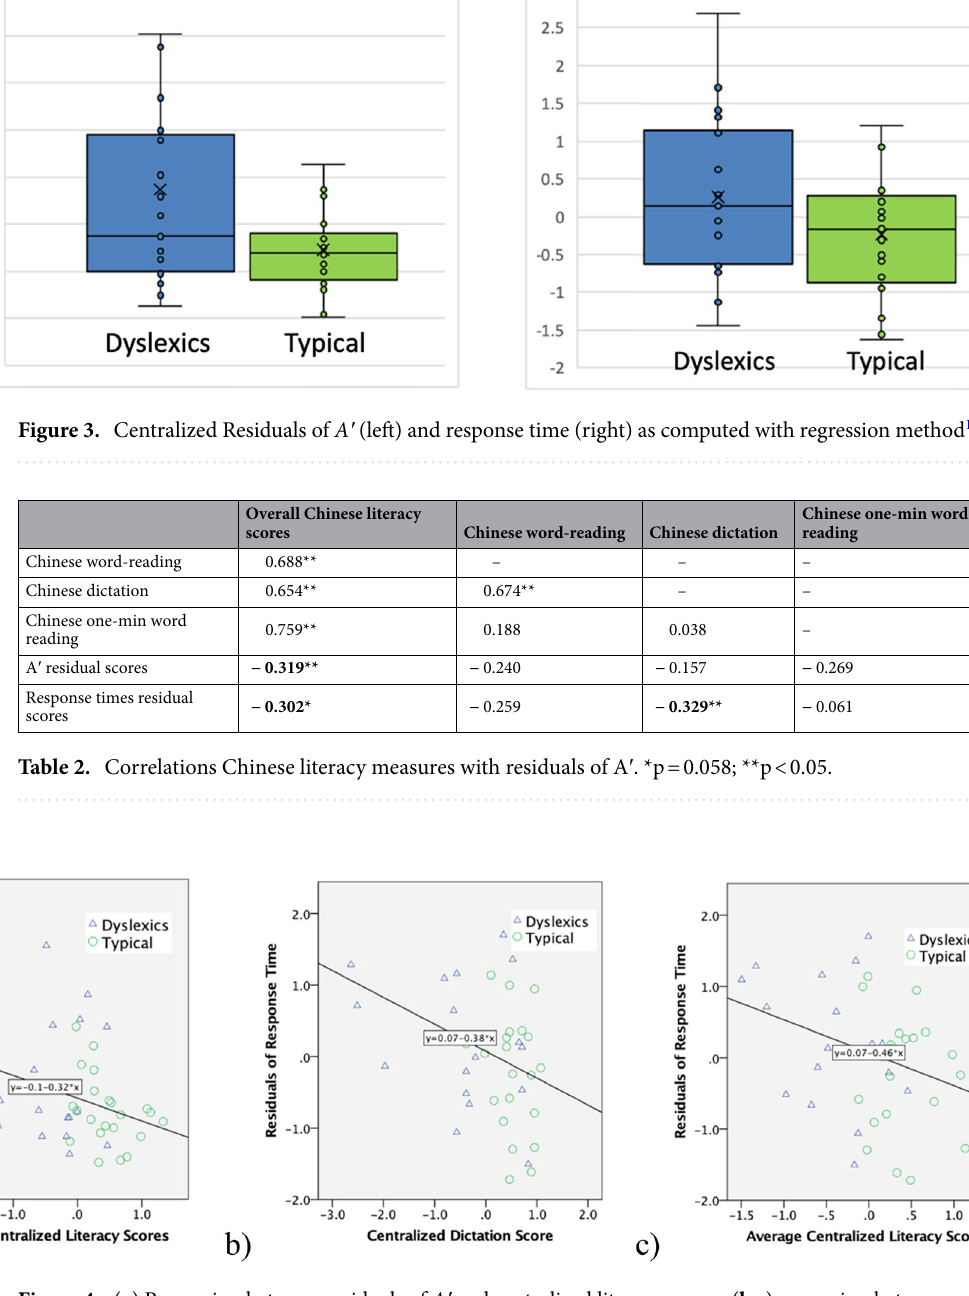
Figure 4. ( a ) Regression between residuals of A ′ and centralized literacy scores; ( b , c ) regression between residuals of response time and centralized literacy and dictation